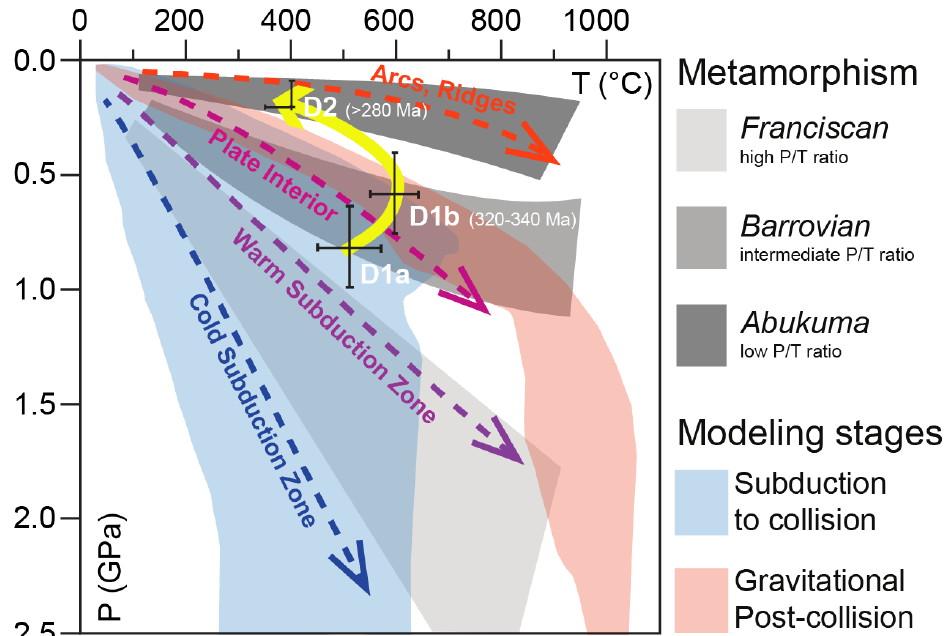
Figure 10. Comparison between the P-T path inferred for the SCB rocks (yellow line with arrow), metamorphic field gradients, and P-T predictions obtained during different stages of a 2D numerical model of Variscan convergence (subduction/post-collisional stages ([99] and refs. therein). Cross signs refer to the P-T conditions attained by the SCB rocks during D1a to D2 deformation stages. Dashed geotherms “Arcs, Ridges”, “Plate Interior”, “Warm Subduction Zones”, and “Cold Subduction Zones” follow [98]. D1a, D1b, and D2 refer to the metamorphic conditions related to the successive groups of structures in SCB. Ages referred to D1b and D2 are inferred from radiometric and stratigraphic data ([49,62,102] and refs. therein).